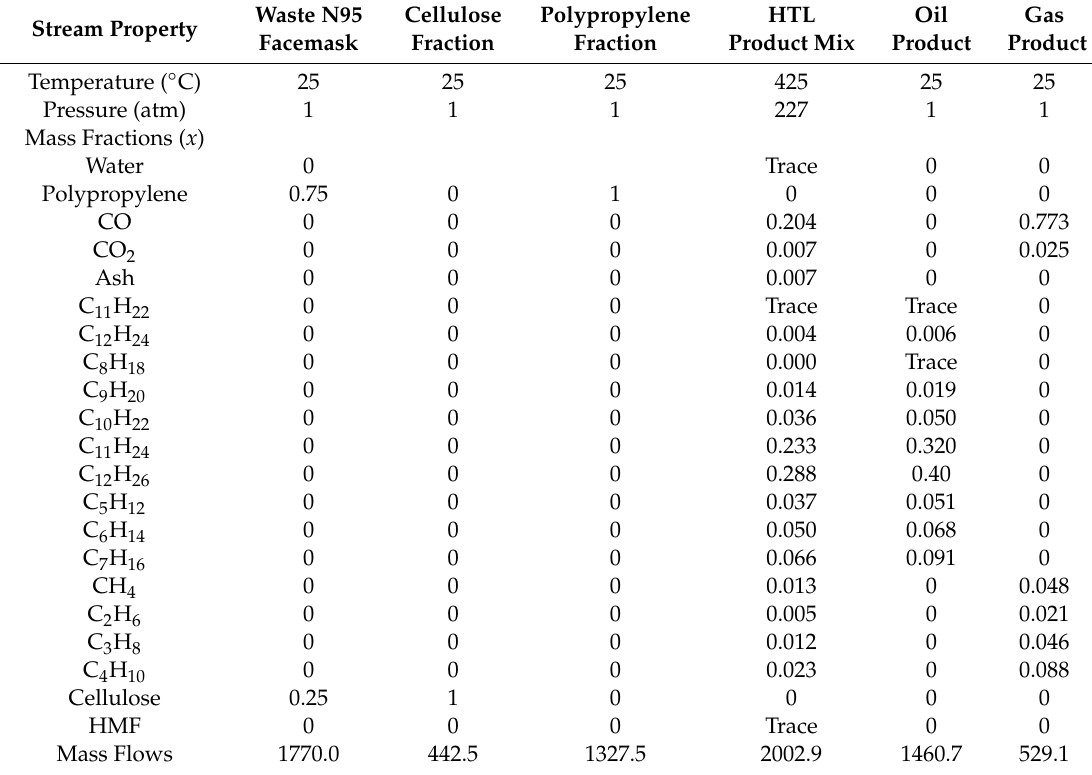
Table 5. Mass balance results for major streams in the process for N95 facemask waste liquefaction for energy-dense oil production (scenario ii).